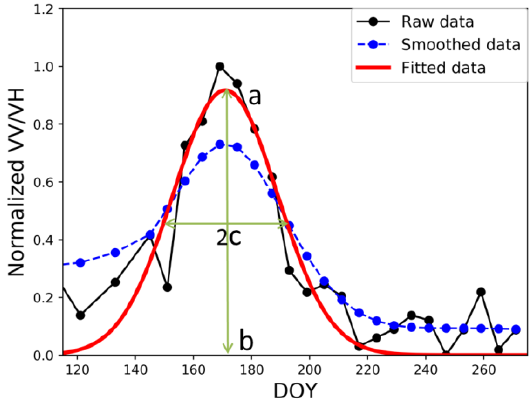
Figure 6. Gaussian fitting of the VV / VH temporal series for a rice plot with the corresponding fitting parameters. Raw normalized data in black, smoothed data in blue and Gaussian fitted data in red.